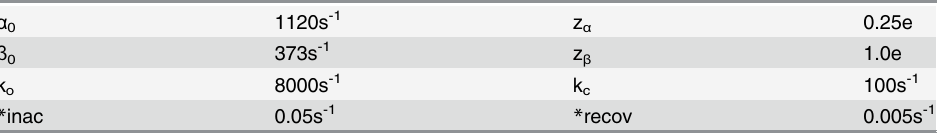
* refers to parameters associated with Scheme